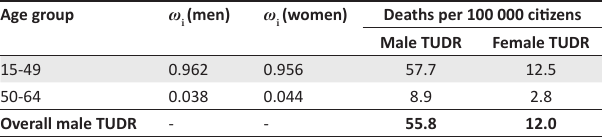
Overall male TUDR 55.8 12.0 Source : The TUDR values and ω i (men; women) were extracted from the South African statistical publications (SSA 2009c, 2011) and calculated using Equations (6) and (7) TUDR, total death rate from unnatural causes.